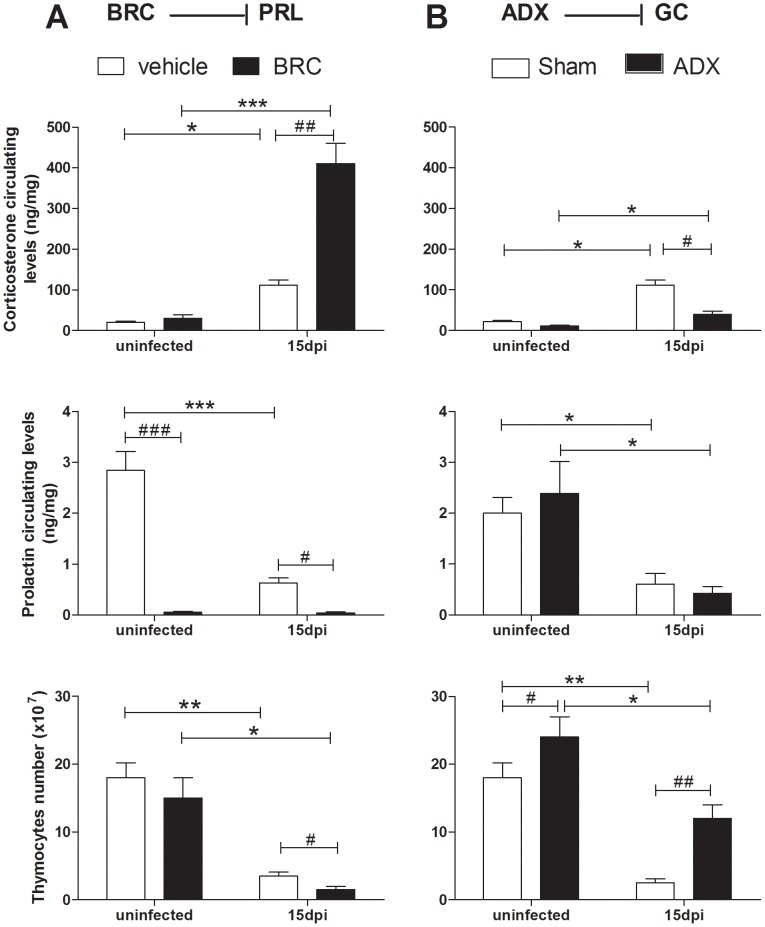
CD4+CD8+ depletion in T. cruzi infected
animals is related to the increased systemic GC levels, subsequent to decrease in serum PRL.In panel A, the effects of the PRL synthesis inhibitor, bromocriptine (BRC) is
shown, whereas the effects of adrenalectomy (thus abrogating adrenal-derived GCs) are seen in panel
B. BRC-induced shutdown of pituitary PRL production increases serum GC levels, but
adrenalectomy does not promote a reciprocal rise in PRL. Moreover, BRC decreases thymocyte numbers
in infected animals, whereas ADX promote a significant increase in the total numbers of these cells.
Infected and uninfected animals were daily given BRC (10 mg/kg/100 µl s.c.) or vehicle alone
for 15 days, when they were killed under non-stressor conditions. Mice were adrenalectomized one
week prior to infection, and sham surgery was performed in control animals. Sera were used for
quantifying PRL (by ELISA) and corticosterone (by radioimmunoassay). Simultaneously, thymuses were
removed and total thymocyte numbers determined. Data are representative of two independent
experiments using five to eight mice per group in each experiment. Statistically significant
differences (p<0.05) between uninfected versus infected (*) or between 8 and 15
dpi (#) mice. *p<0.05; **p<0.01, ***p<0.001.